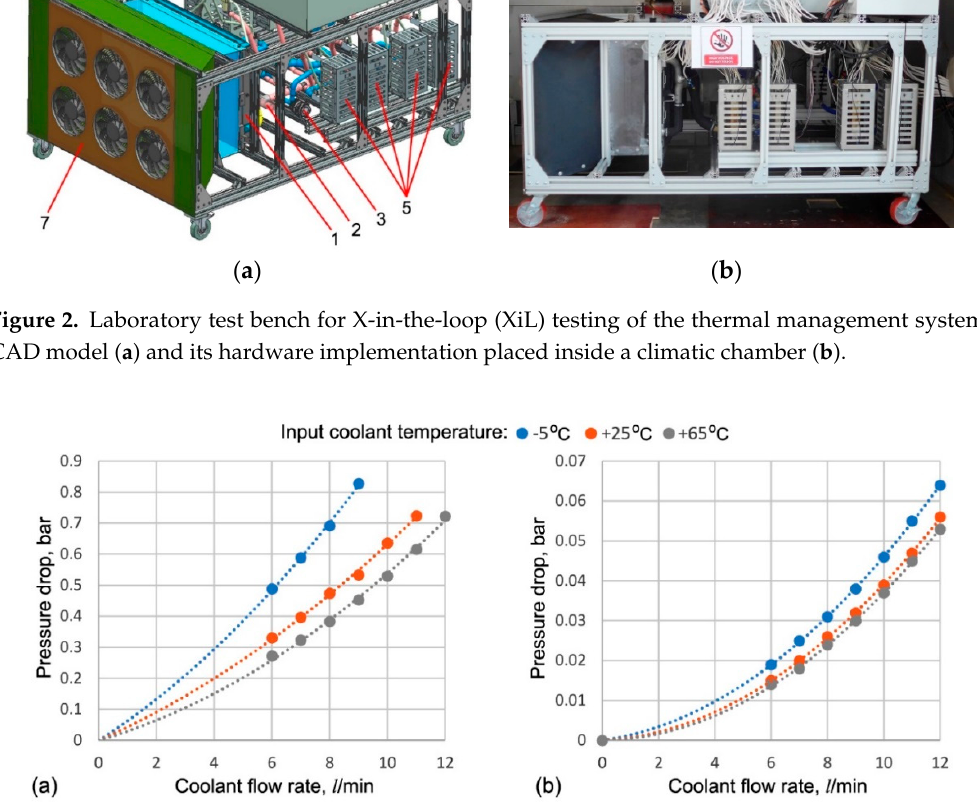
Figure 3. Hydraulic resistances of the cooling jackets: ( a ) Electric motor (experimental data and their second-order fit), ( b ) inverter (computational fluid dynamics (CFD) data and their second-order fit).